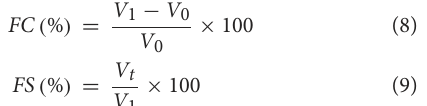
1min. The volume of foam was recorded at 0, 10, 20, 30,